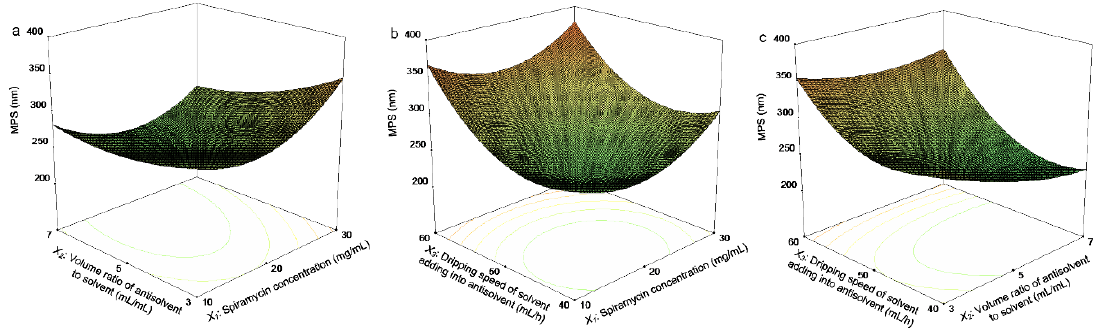
Figure 4. The response surface for the effect of independent variables on MPS of micronized spiramycins: ( a ) the spiramycin concentration and volume ratio of antisolvent to solvent; ( b ) the spiramycin concentration and dripping speed of the solvent adding into the antisolvent; and ( c ) the volume ratio of the antisolvent to solvent and dripping speed of the solvent adding into the antisolvent.